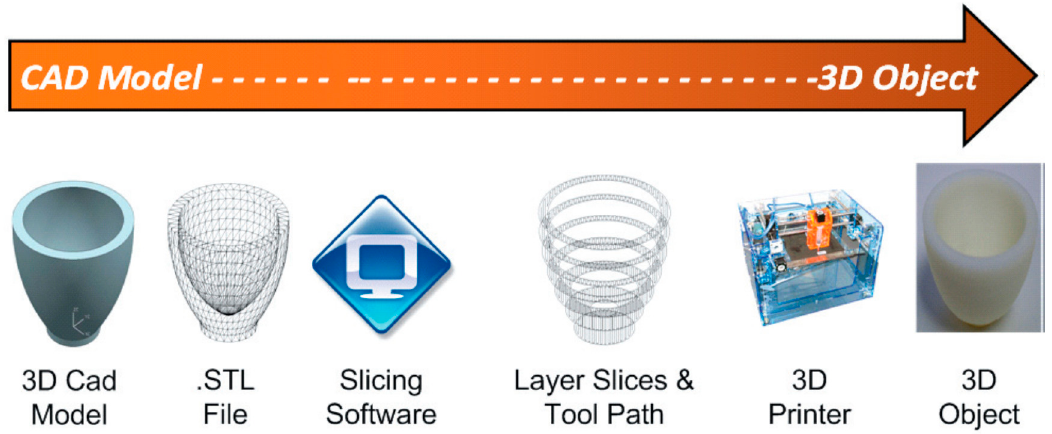
Figure 1. The 3D printing process (adapted with permission from reference [18]).